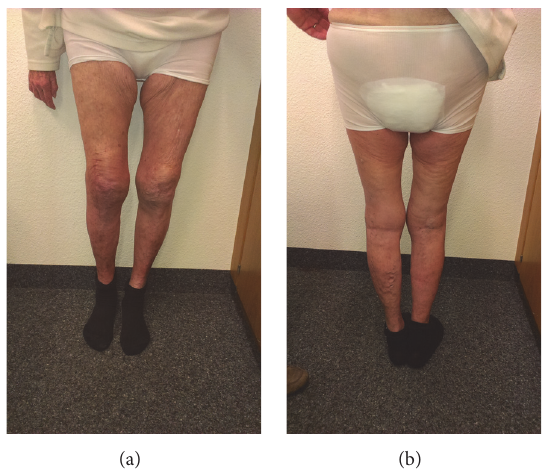
Figure 3: Postoperative anterior (a) and posterior (b) view images of the patient standing. Visual inspection with normal tibiofemoral